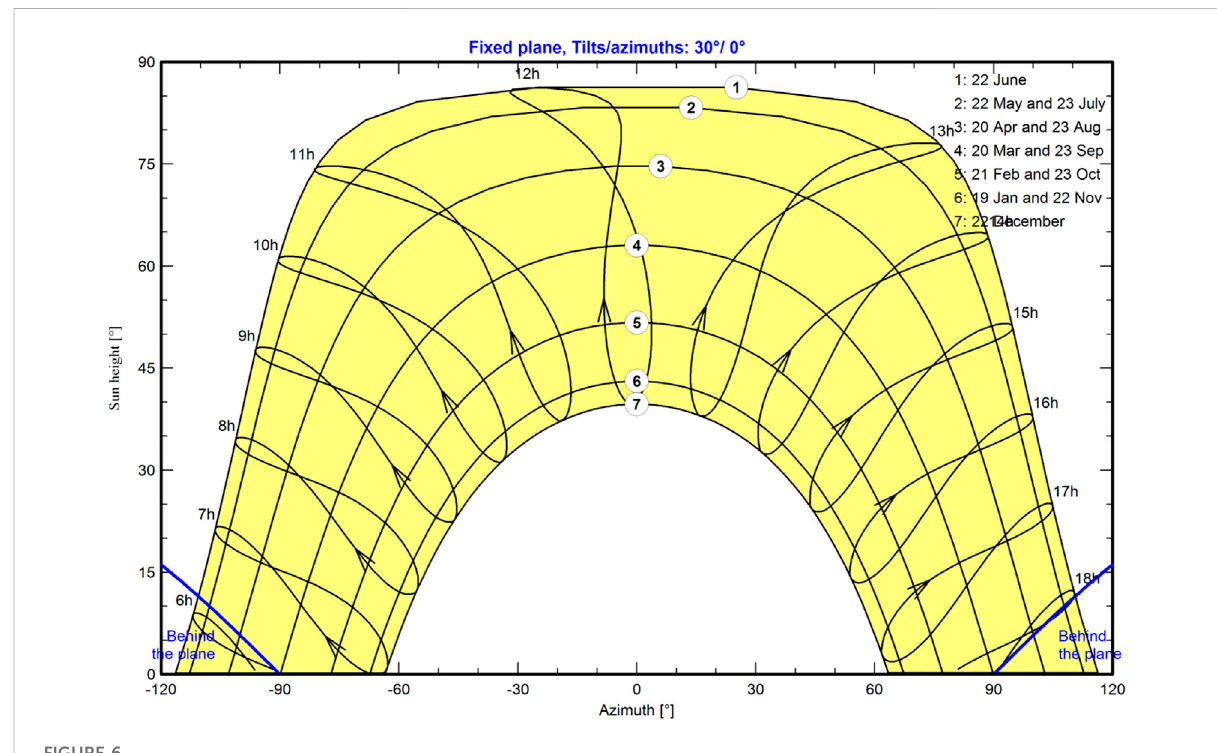
FIGURE 6 Sun paths height/azimuth plot within PV*Syst.